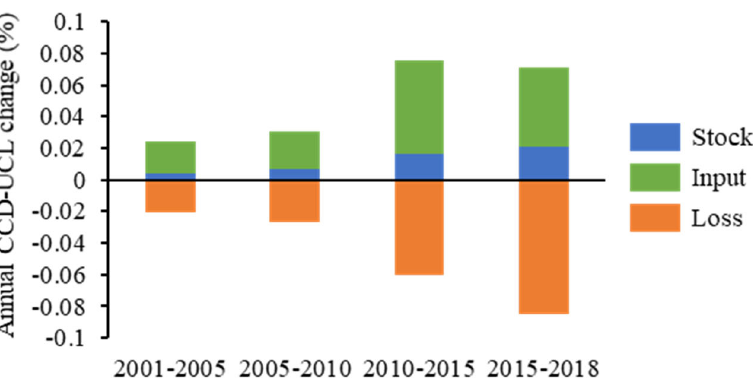
Figure 8. Stock, input, and losses of CCD related to UCL.